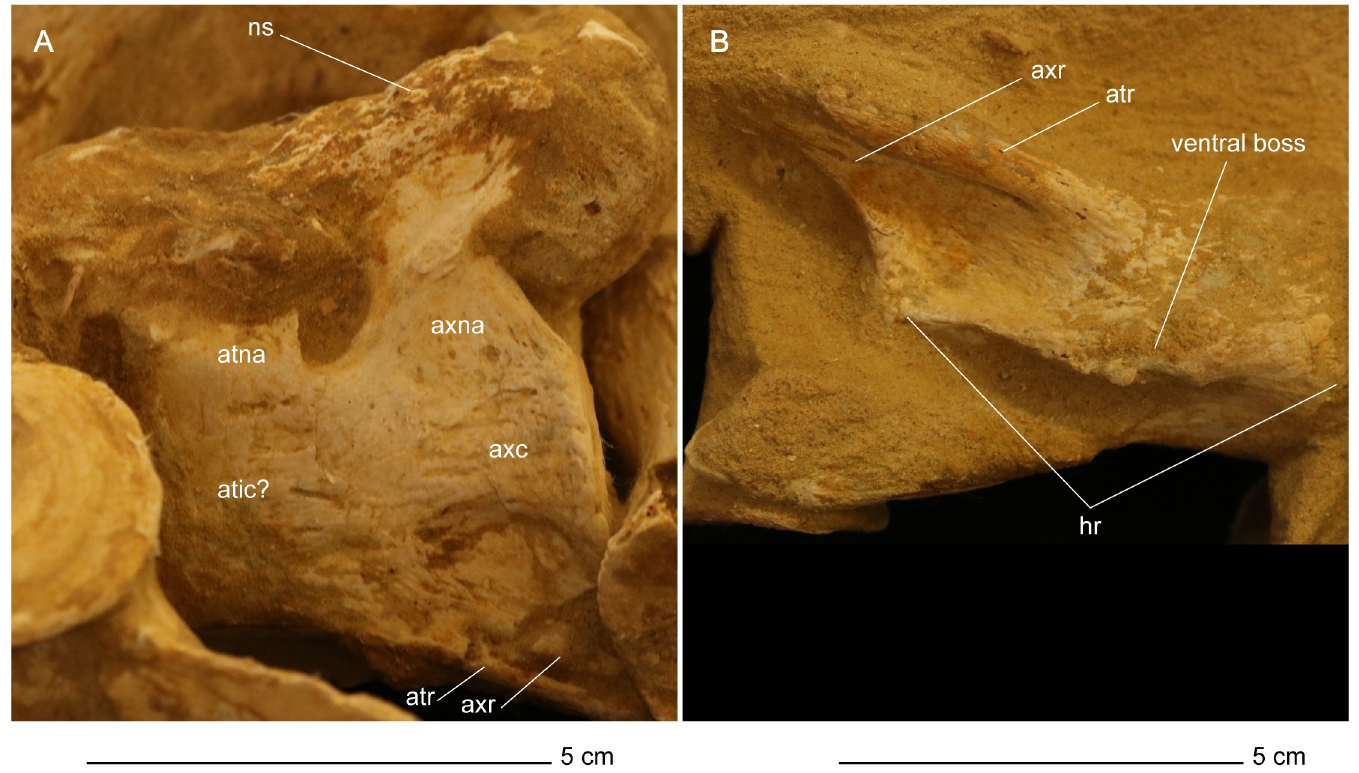
Fig 18. Atlas-axis complex of Cardiocorax mukulu (MGUAN PA278). A. Left lateral view. B. Ventral